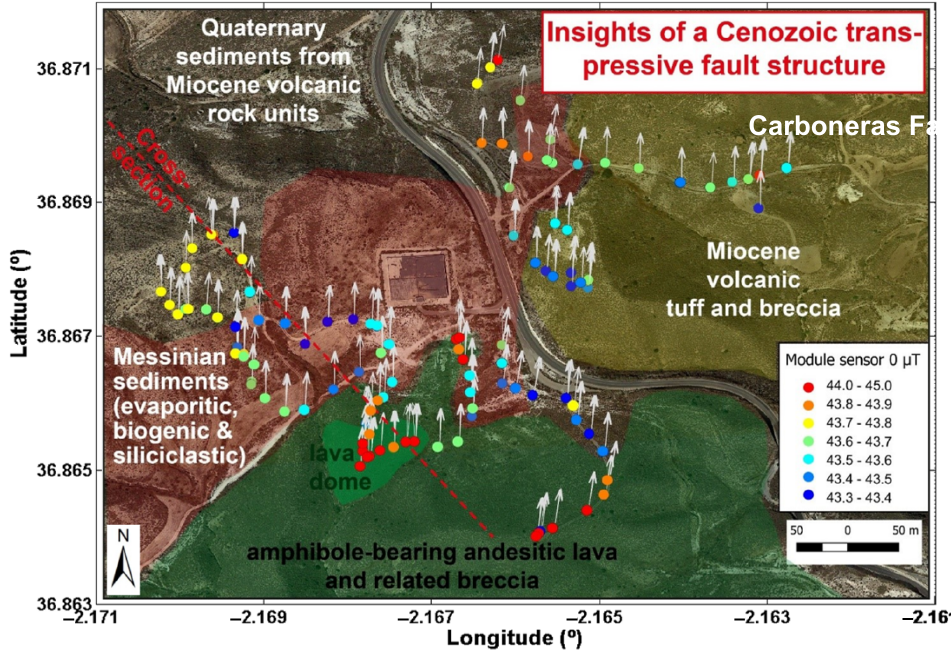
Figure 19. Experimental values of the magnetic field anomaly of the Carboneras Fault: intensity and direction registered by the on-ground equipment. Graph concerning the track corresponding to the overflight of the hypothesized lava dome.